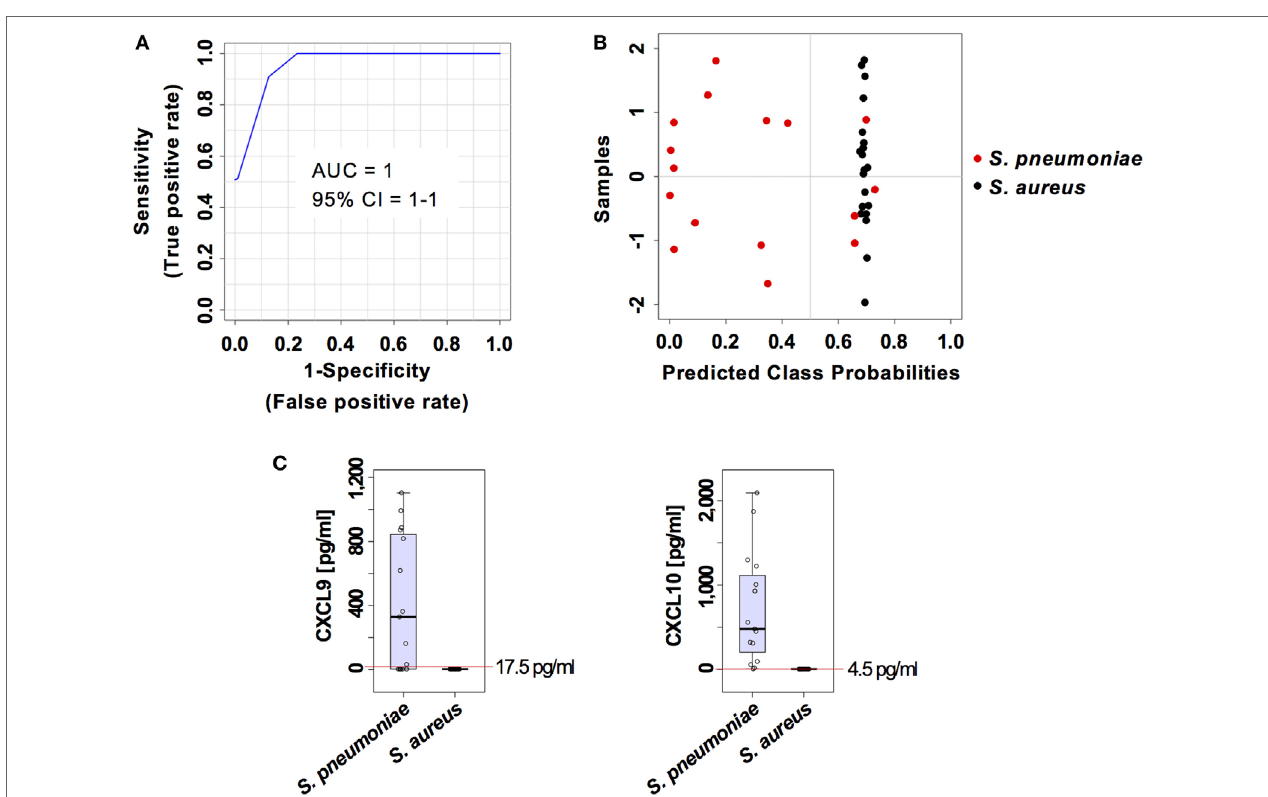
FigUre 8 | External validation of the predictive model built on the two set biomarkers CXCL9 and CXCL10. (a) Receiver operating characteristic curve and area under the receiver operating characteristics curve (AUC) value of the predictive model built combining the serum levels of CXCL9 and CXCL10 calculated using Monte Carlo cross-validation. (B) Plot of posterior classification probability showing the segregation of Streptococcus pneumoniae (red symbols) and Staphylococcus aureus (black symbols) infection samples according to the set of the two biomarkers CXCL9 and CXCL10, using a predictive model in an external cohort of C57BL/6 mice. Each symbol represents the classification probability that a given infected sample belongs to the S. pneumoniae or to the S. aureus group. The classification boundary is shown by a dotted line at x = 0.5. (c) Box-and-whisker plots illustrating the concentrations of CXCL9 and CXCL10 in serum of S. pneumoniae- infected or S. aureus- infection mice. The red line indicates the metabolite concentration cutoff value for sensitivity and specificity of 1 and the corresponding numeric value is included in each